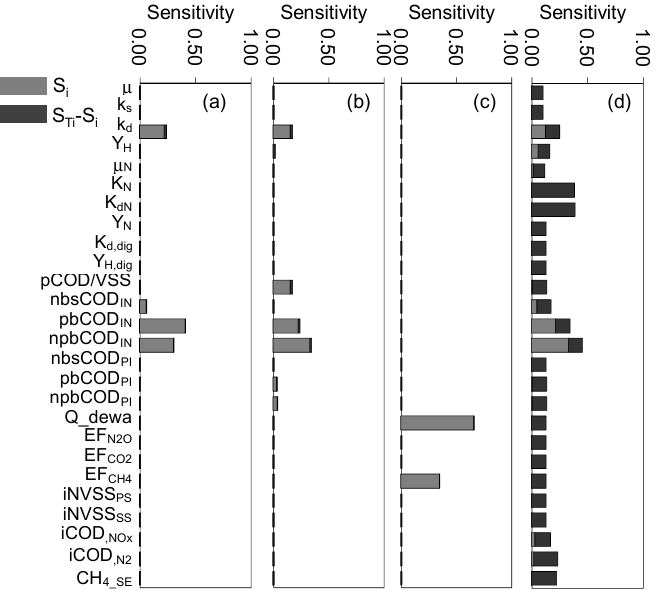
Figure 6. Sensitivity (S i ) and interaction (S Ti − S i ) of all factors for ( a ) CO 2_resp ; ( b ) CH 4_comb ; ( c ) CH 4_dewatering and ( d ) Power